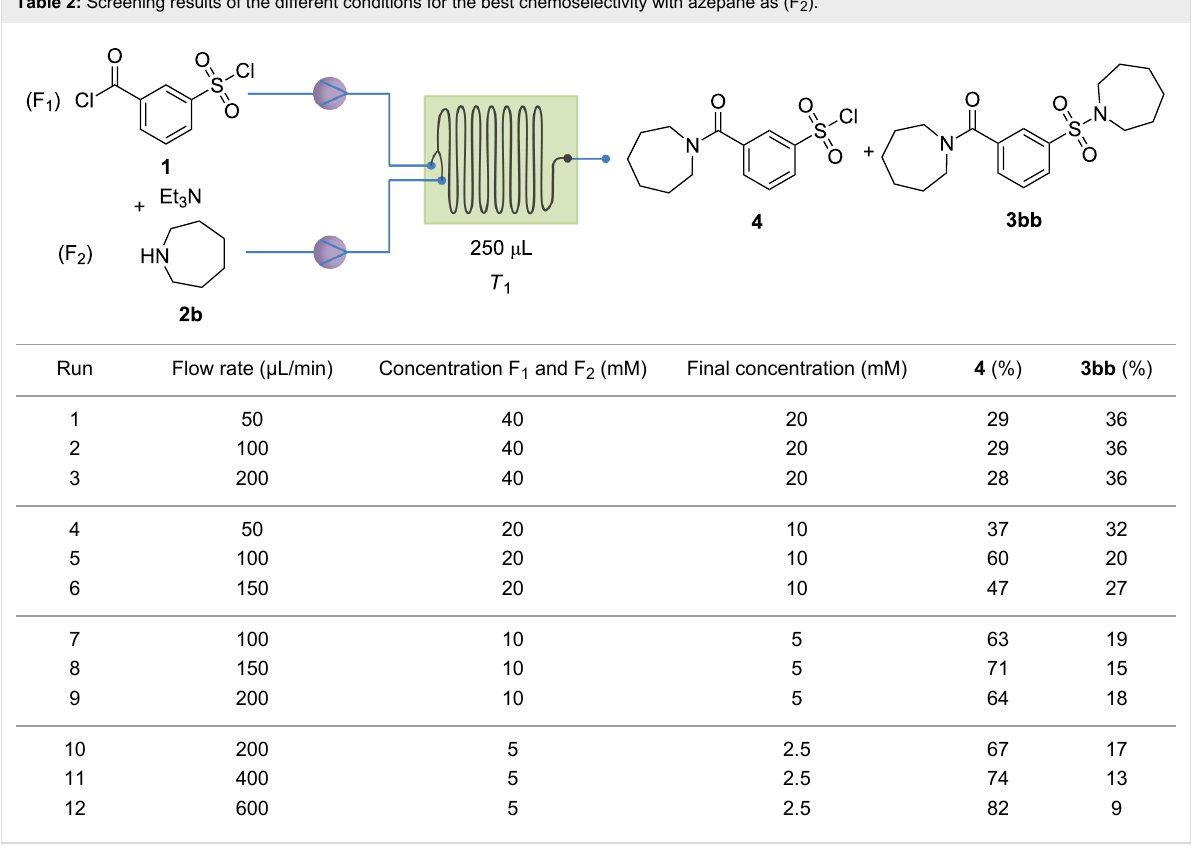
Table 2: Screening results of the different conditions for the best chemoselectivity with azepane as (F 2 ).